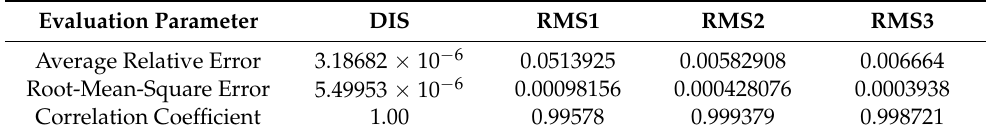
Table 3. Evaluation results of the trained surrogate model.